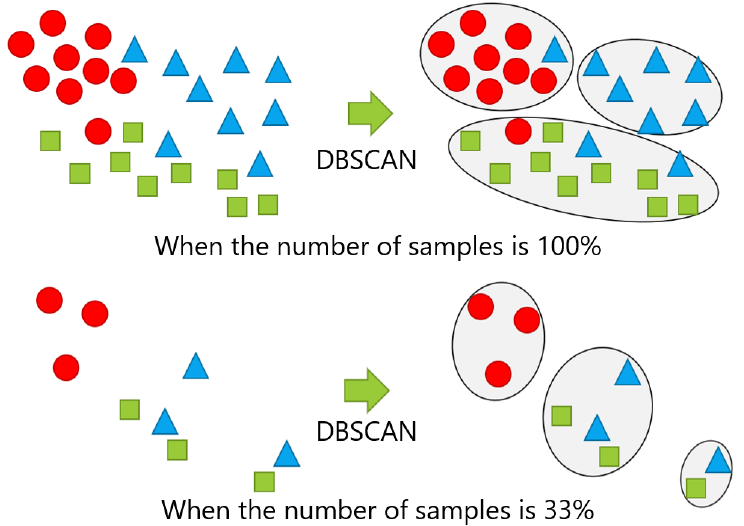
Figure 12. Example of changing the number of samples: The top and bottom are the cases performing DBSCAN with 100% and 33% of the samples,